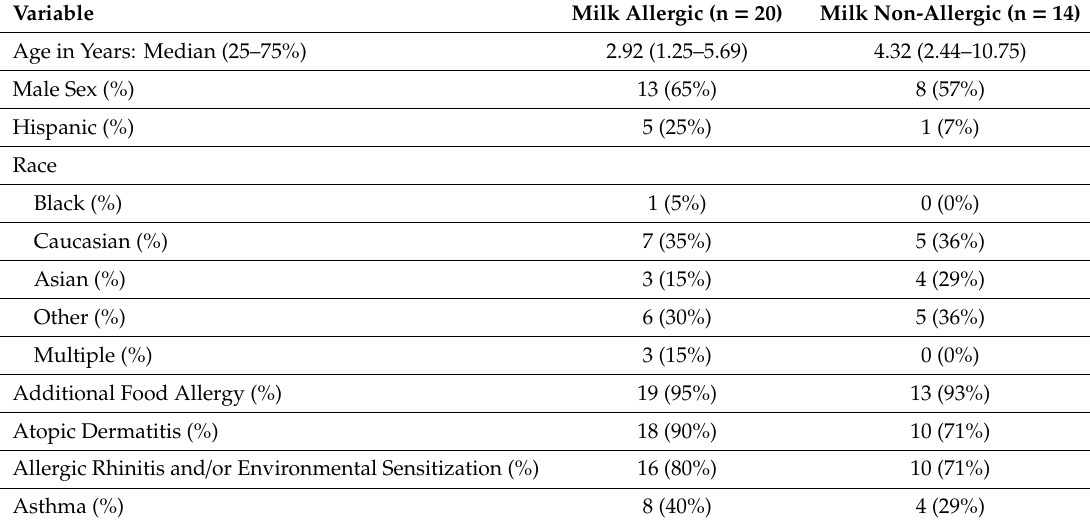
Table 1. Patient characteristics.